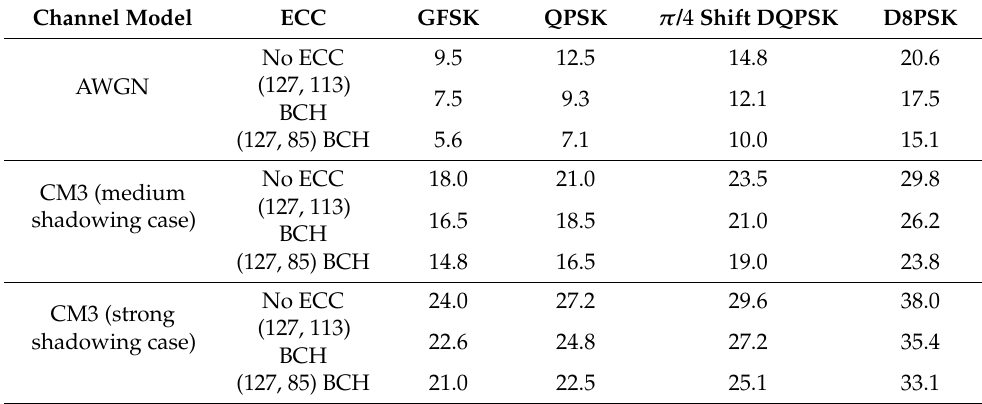
Figure 10. Energy efficiency in the case of several channel models. ( a ) AWGN. ( b ) IEEE model CM3 (medium shadowing case, K = 4.5). ( c ) IEEE model CM3 (strong shadowing case, K = 0.14). Table 8. E s / N 0 (dB) satisfying a packet error ratio (PER) ≤ 10 − 2